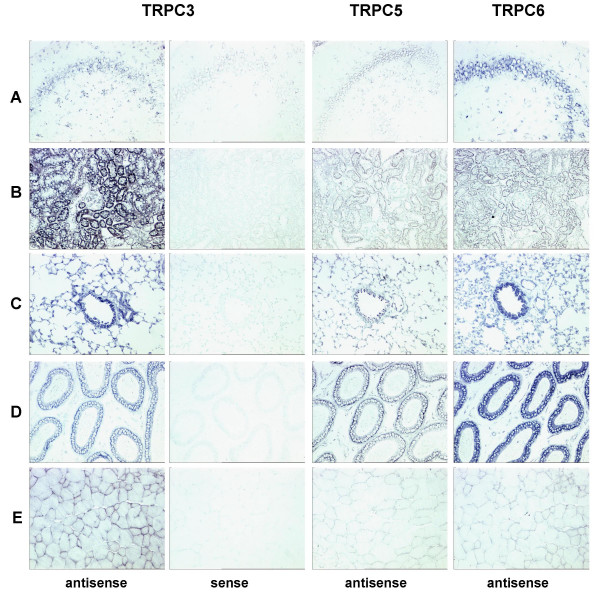
In situ localization of three TRPC mRNAs in different mice organs using in situ hybridization. In situ hybridization of TRPC3, TRPC5 and TRPC6 mRNA was performed with tissue sections of adult (100d) C57Bl/10SC mice. The two left hand columns of sections were incubated with the antisense probe for TRPC3 and the sense probe (control), respectively. For TRPC5 and TRPC6 only results with antisense probes are shown. Tissue sections: A: hippocampus, B: Kidney, C: Lung, D: epididymis, E: skeletal muscle. In all cases a methyl green counter-staining was performed. Magnification: × 200.